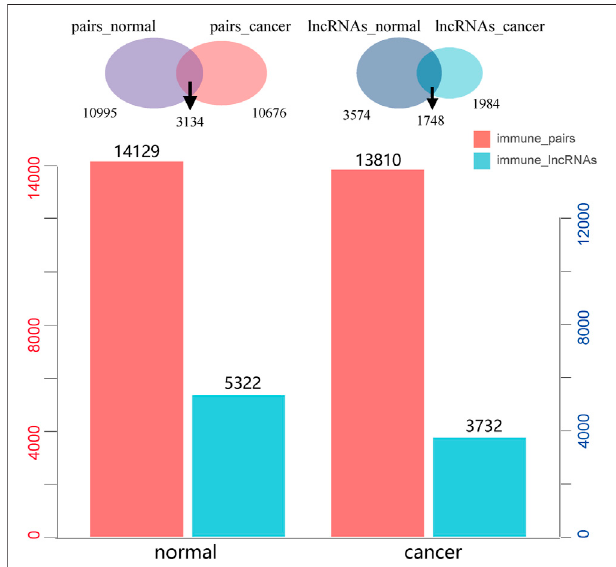
FIGURE 2 | The number of long non-coding RNA (lncRNA) – immune pathway pairs recognized in liver cancer and normal samples and the number of immunological function lncRNAs, in which red represents lncRNA – immune function pairs and blue represents lncRNAs enriched in immune function.